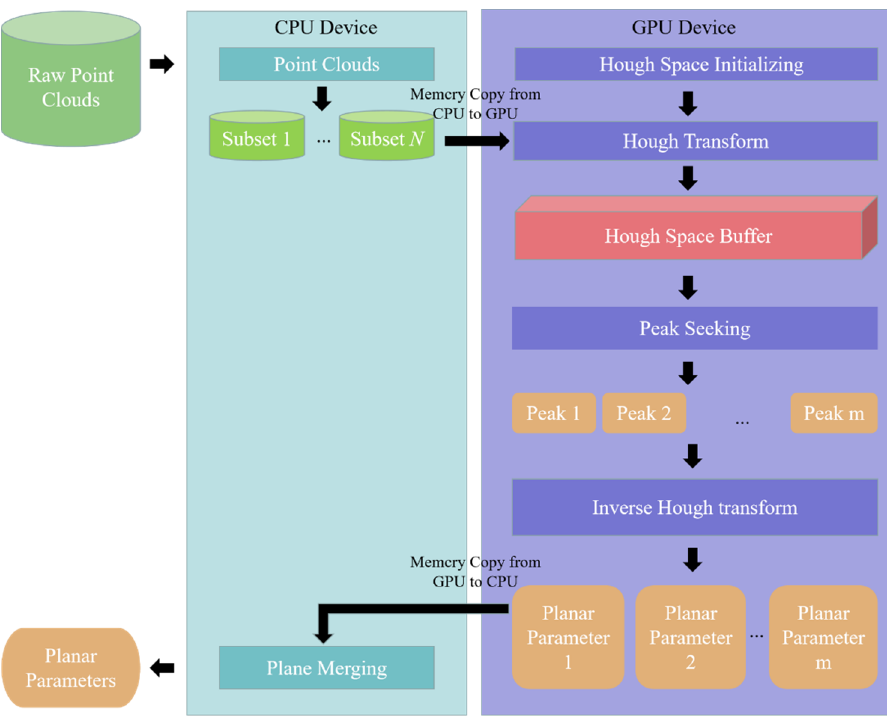
Figure 5. CPU–GPU hybrid architecture of fast planar detection system.